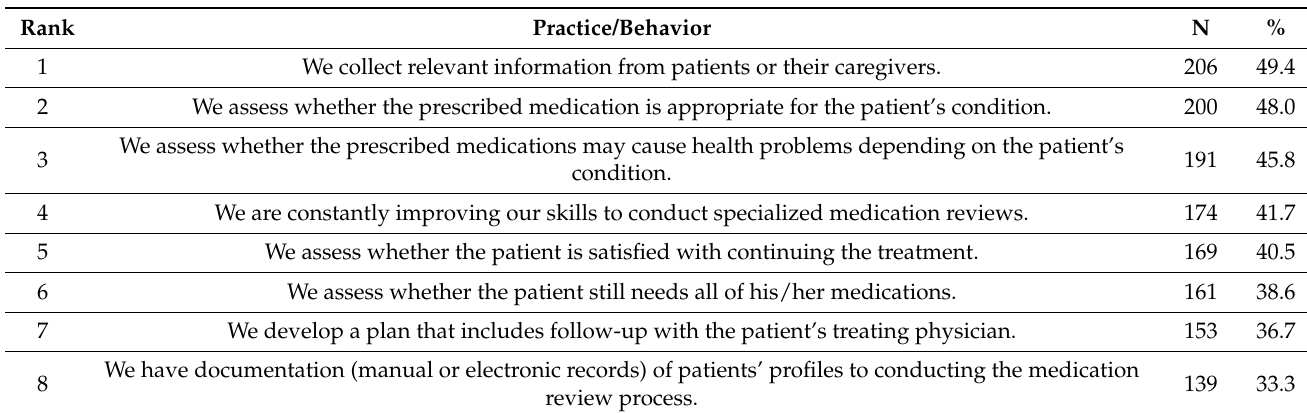
Table 2. Medication review process (MRP) practices and behaviors performed by community phar- macists in Jordan (N =